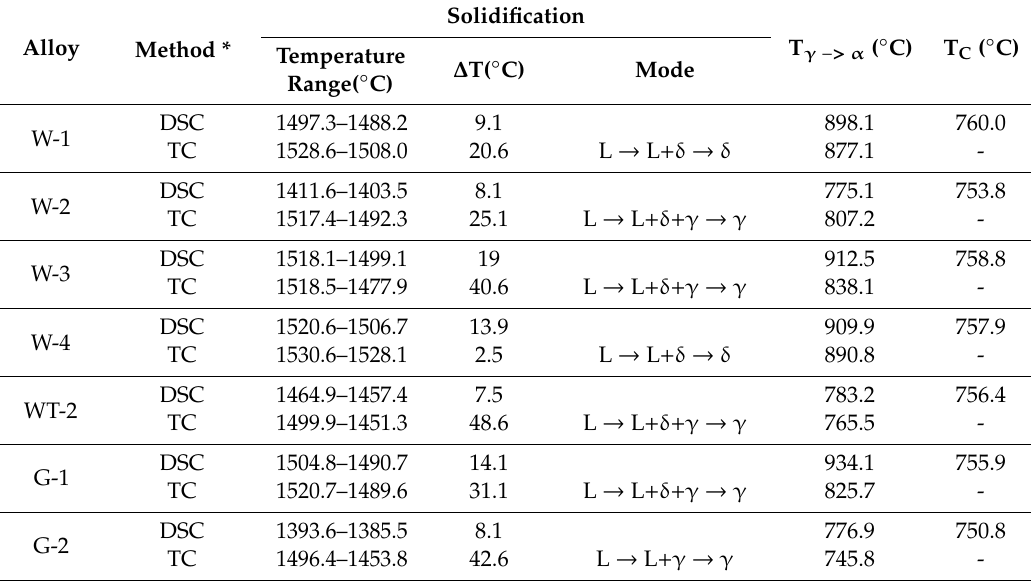
Table 4. Solidification ranges and critical transformation temperatures of the steel